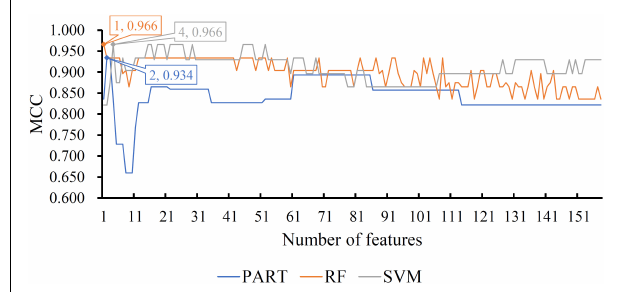
FIGURE 4 | IFS curves with different classification algorithms on different number of methylation features for ERC brain structure. The RF, SVM, and